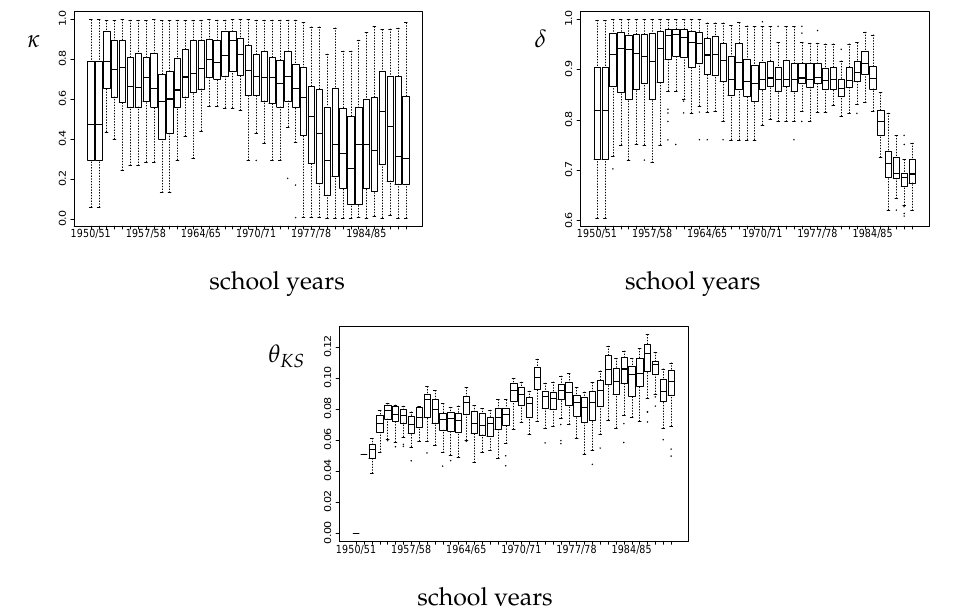
Figure 6. Left top: boxplot of the distribution of κ for the 50 best runs (out of 660 runs), right top: boxplot of the distribution of δ for the 50 best runs (out of 660 runs), bottom: boxplot of the distribution of θ KS for the 50 best runs (out of 660